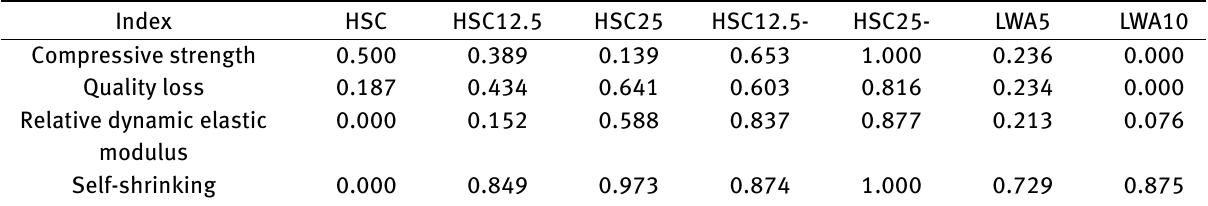
Table 4: Judgment